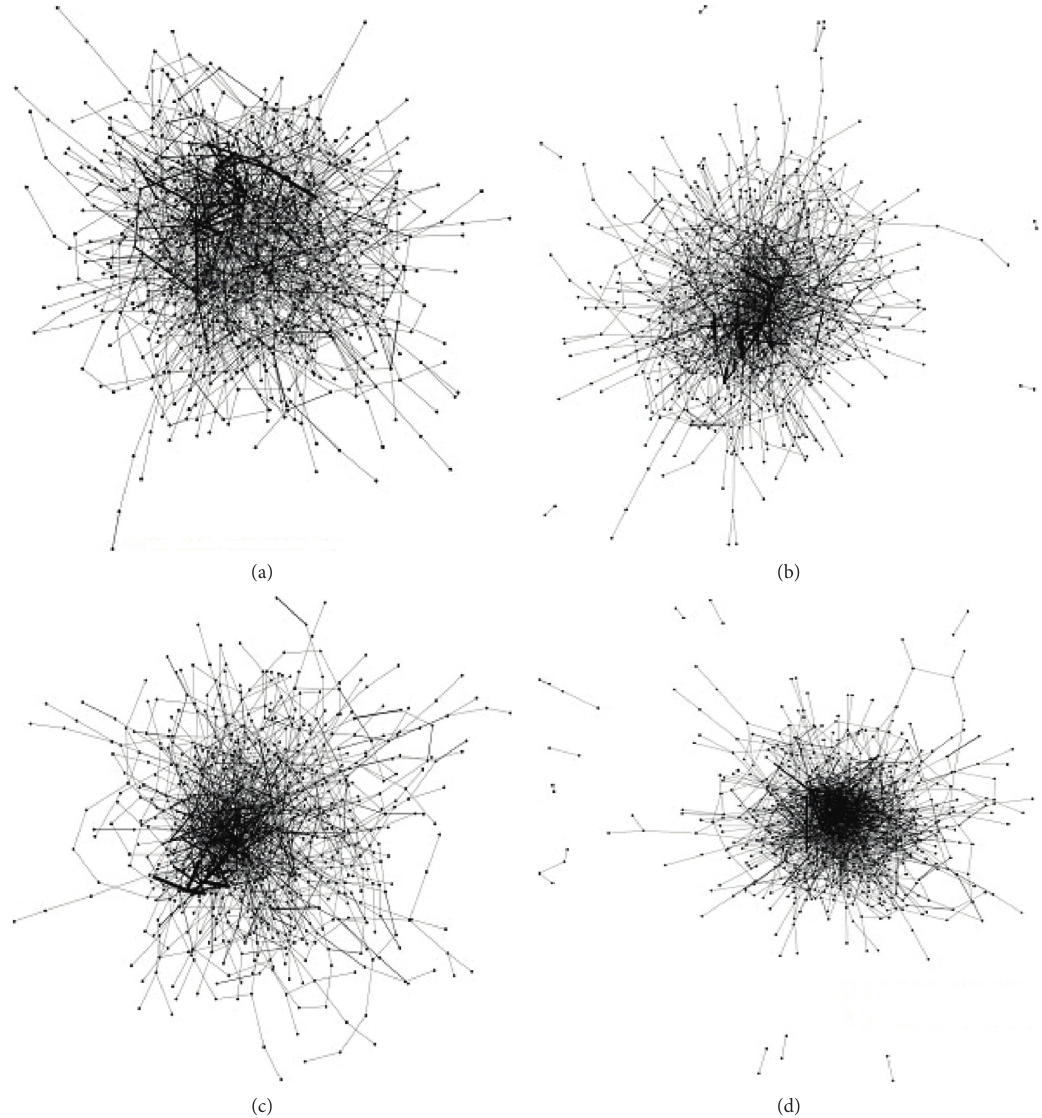
Figure 5: Network structures under different transformation costs: (a) Cu � 2, Cb � 4; (b) Cu � 1.5, Cb � 3; (c) Cu � 1, Cb � 2; (d) Cu � 0.5, Cb � 1.